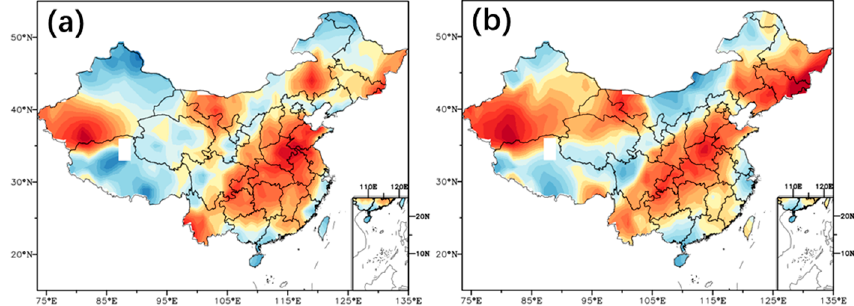
Figure 2. ( a ) Composite maximum surface air temperature (SAT) anomalies for 15 July–15 August. The extreme hot region (region A) for the heatwave is marked with black lines. The region in the parallelogram (region B) is used to study the evolution of the heatwave. Two hot spots in region A are denoted by green lines (region C) and blue lines (region D), respectively. ( b ) Time-latitude evolution of normalized SAT anomalies averaged over region B, where the thick black arrow denotes the movement of the hot region. Variations in the domain-averaged SAT anomalies (blue line with dots) for region C and region D are shown in ( c ) and ( d ). The red dashed lines indicate the 0.75 ( − 0.75) standard deviation and the four hot periods selected by the 0.75 standard deviation are marked by transparent green shadings.